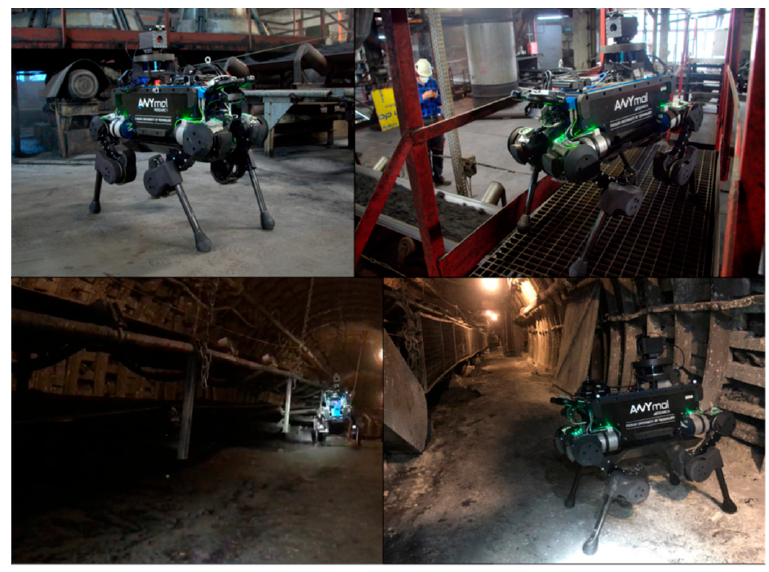
Figure 19. ANYmal legged robot by ANYbotics in various mining conditions (Reprinted from Ref.